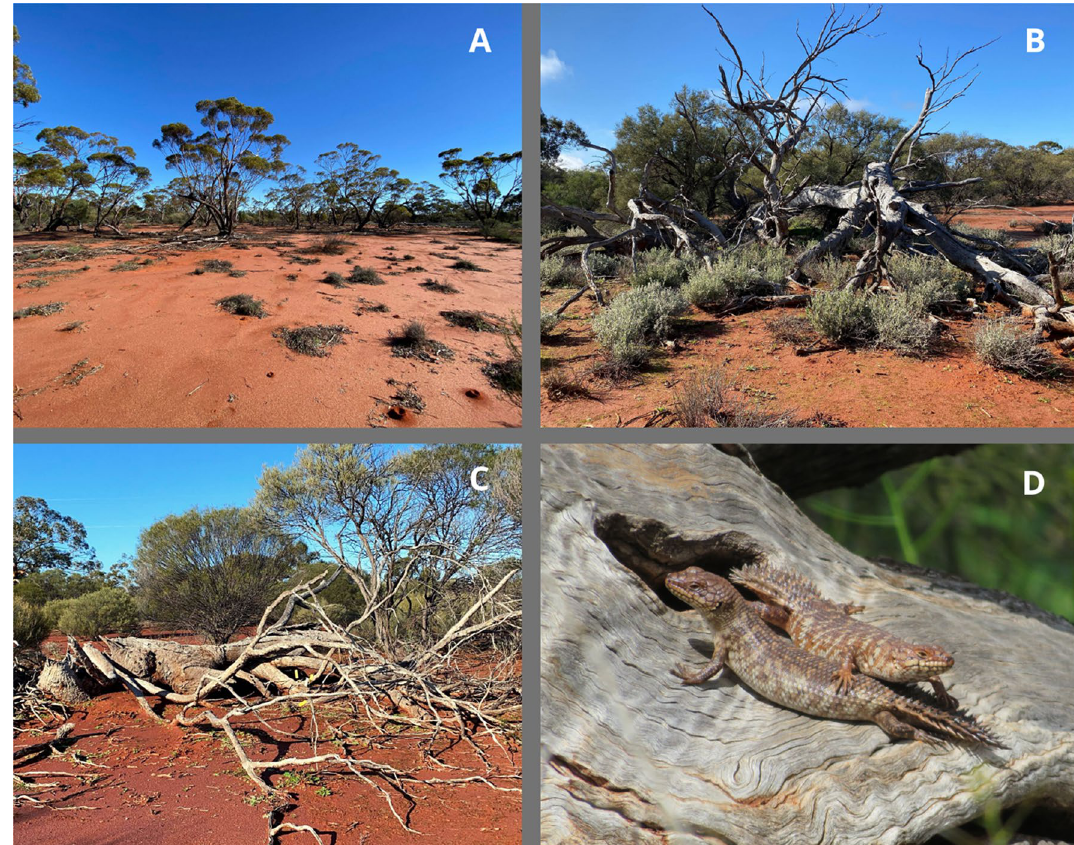
Figure 1. Typical habitat of the skinks in the Mid West region of Western Australia; ( A ) open Eucalyptus woodland in which log piles were sparsely distributed; ( B and C ) examples of log piles inhabited by skink colonies; and ( D ) juvenile skinks basking by one of the hollows of an occupied log pile. Photos: H